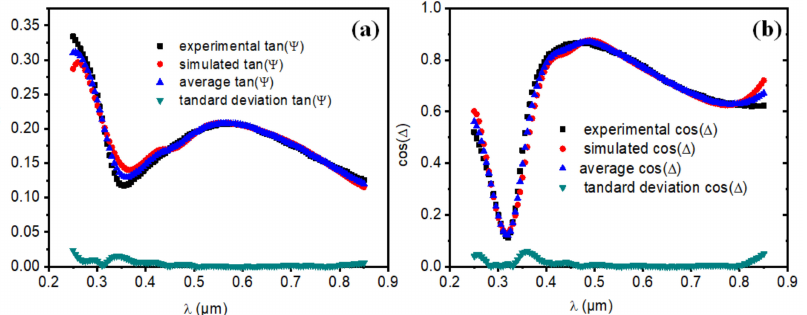
Figure 6. ( a ) Experimental, simulated, average experimental, and standard deviation plot of tan( Ψ ), ( b ) Experimental, simulated, average experimental, and standard deviation plot of cos ( ∆ ).